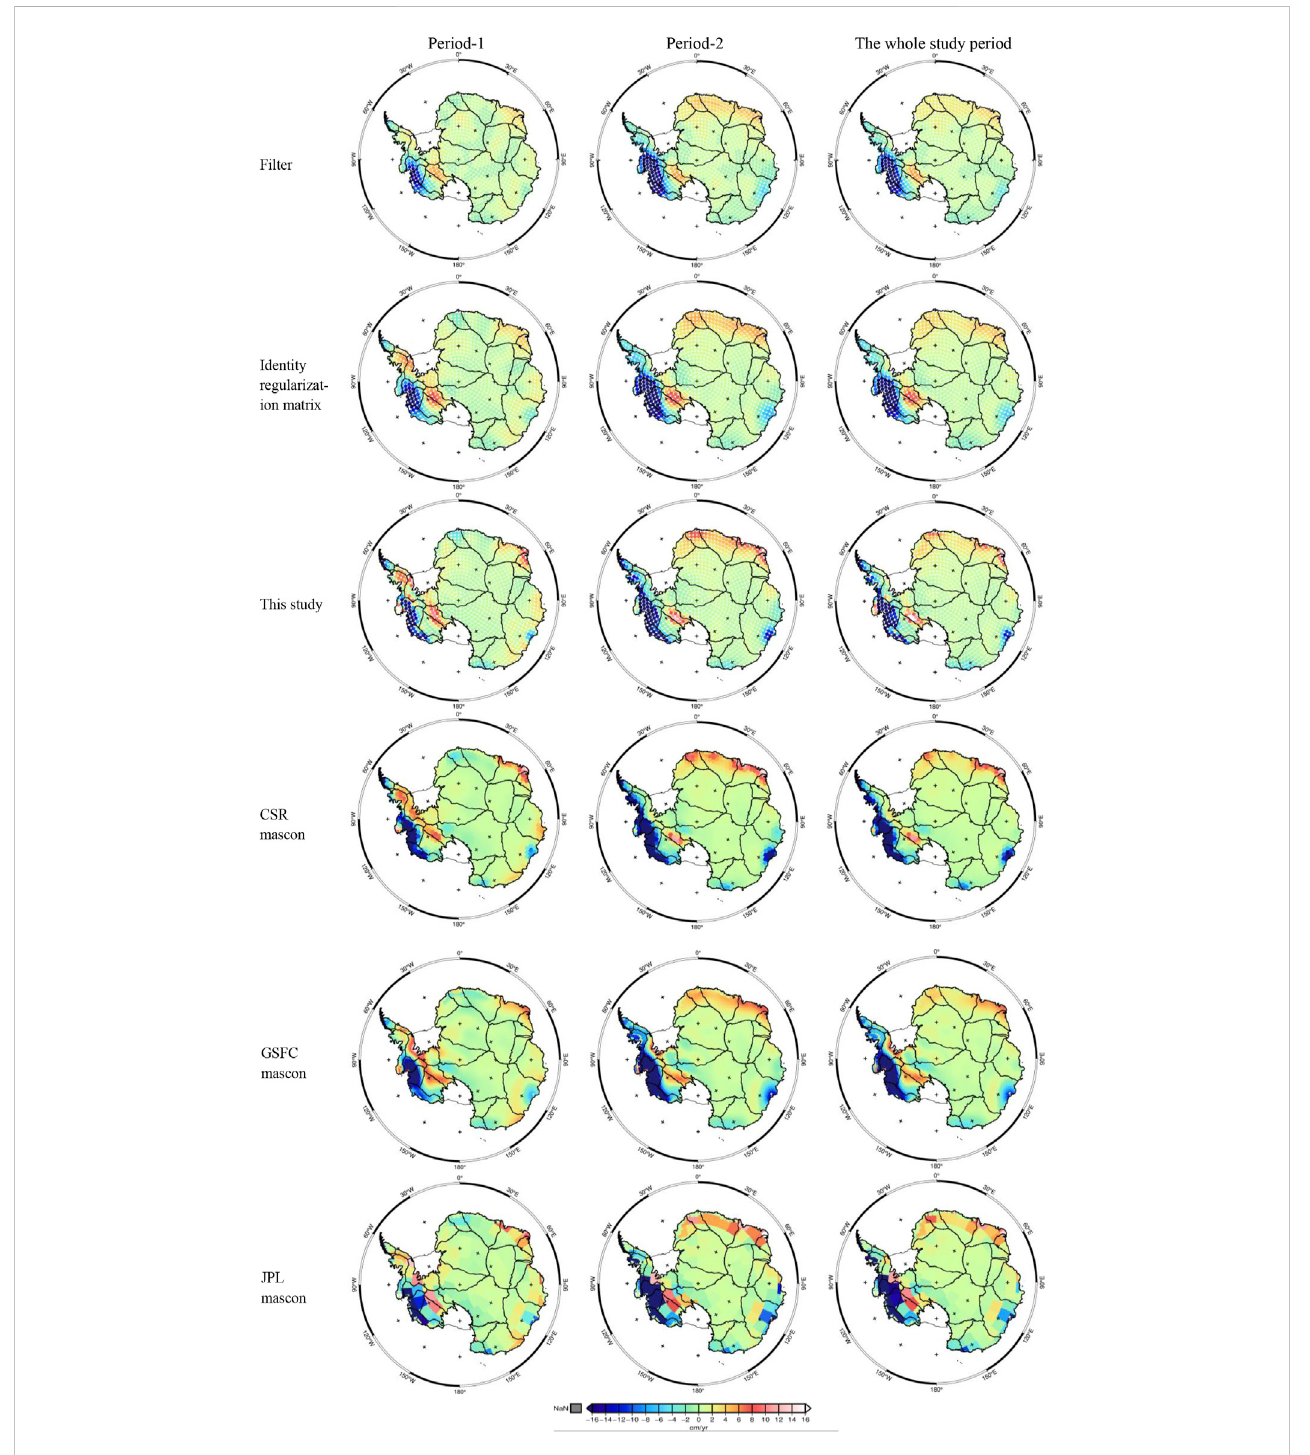
FIGURE 10 Spatial distribution of mass change rates over AIS from April 2002 to December